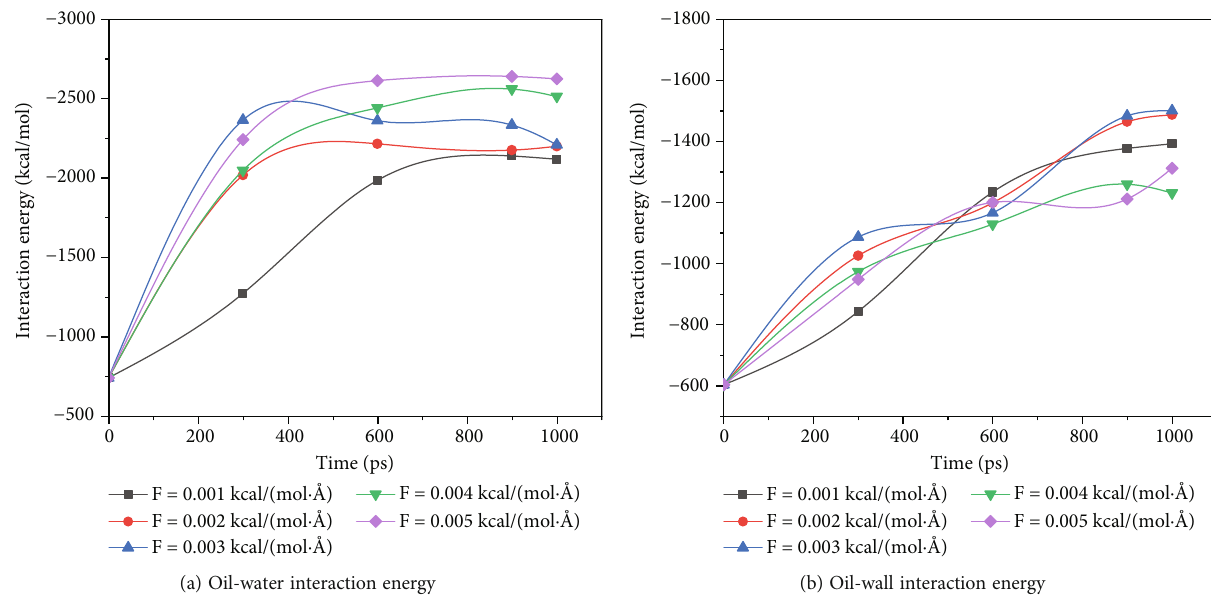
Figure 8: Variation trend of interaction